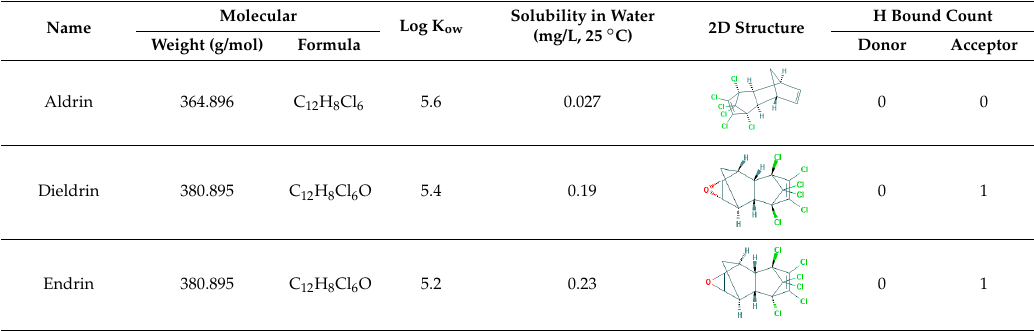
Table 10. Characteristics of Aldrin, Dieldrin, Endrin, Chlordane, Heptachlor, Heptachlor epoxide, Toxaphene 8 [26].